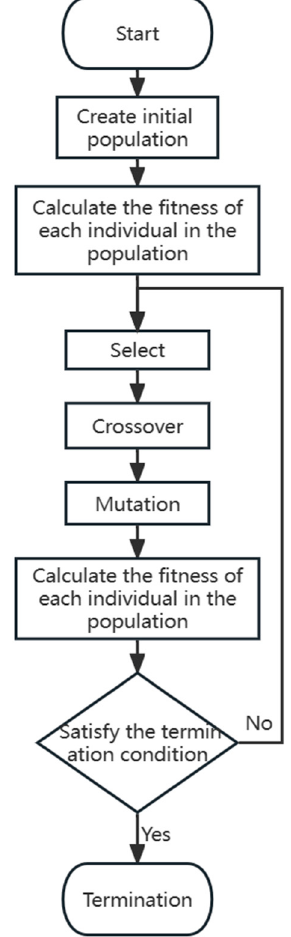
Figure 3. Genetic algorithm flow chart. (Step 1) Initialization of parameters, initial population N = 60, maximum number of iterations G = 100, number of chromosomes C = 6, crossover probability P c = 0.9, variation probability P m = 0.1, and iteration counter t =